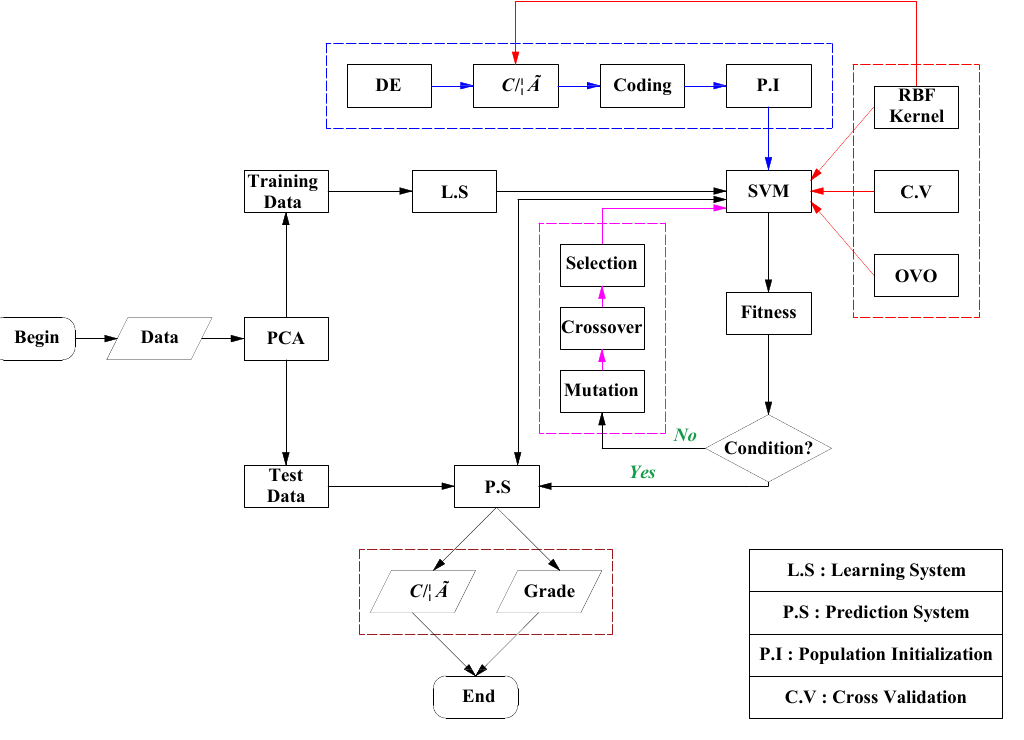
Figure 4. Integrated workflow chart.